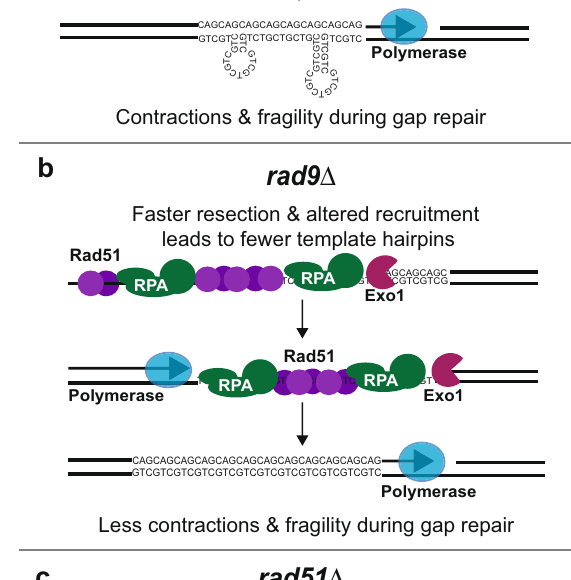
Fig. 7 | A model for repeat instability during resection and gap fi lling at a CTG repeat. a In wildtype cells, as resection occurs, Rad9 controls the recruitment of RPA and Rad51 to ssDNA. Delayed binding of RPA or Rad51 results in hairpin for- mation. Contractions are a result of hairpin bypass during polymerase mediated gap fi lling (shown) or by SSA/end-joining events within the broken CTG repeat region (Supplementary Fig. 3g). In addition, exposed ssDNA results in increased breakage and alternative repair. b In rad9 Δ mutants, there no delayed recruitment of RPA and Rad51 to the freshly resected ssDNA. This prevents hairpin formation and breakage at the repeat tract resulting in increased viability and decreased contractions. c In rad51 Δ , initiation of resection is delayed. Absence of Rad51 and slowed gap fi lling both allow for increased DNA structure formation and contrac- tions. Breaks that occur at the CTG repeat tract cannot repair via BIR leading to increased cell